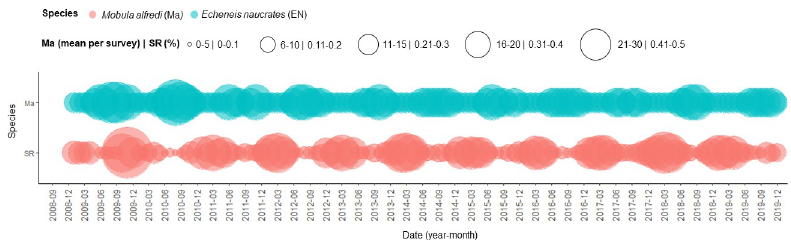
Fig 7. Time series plot showing Mobula alfredi sightings and Echeneis naucrates presence. The total monthly number of Mobula alfredi sightings 2008–2019, and the percentage of those that had Echeneis naucrates